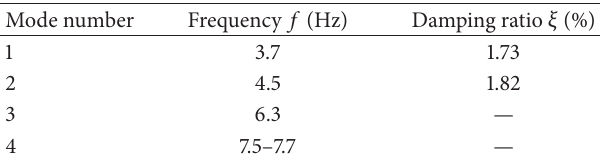
Figure 10: Empirical transfer function derived for the crown cantilever vertical section during both ambient vibration tests. Table 3: Experimental vibration properties of Punta Gennarta Dam—March 2013.